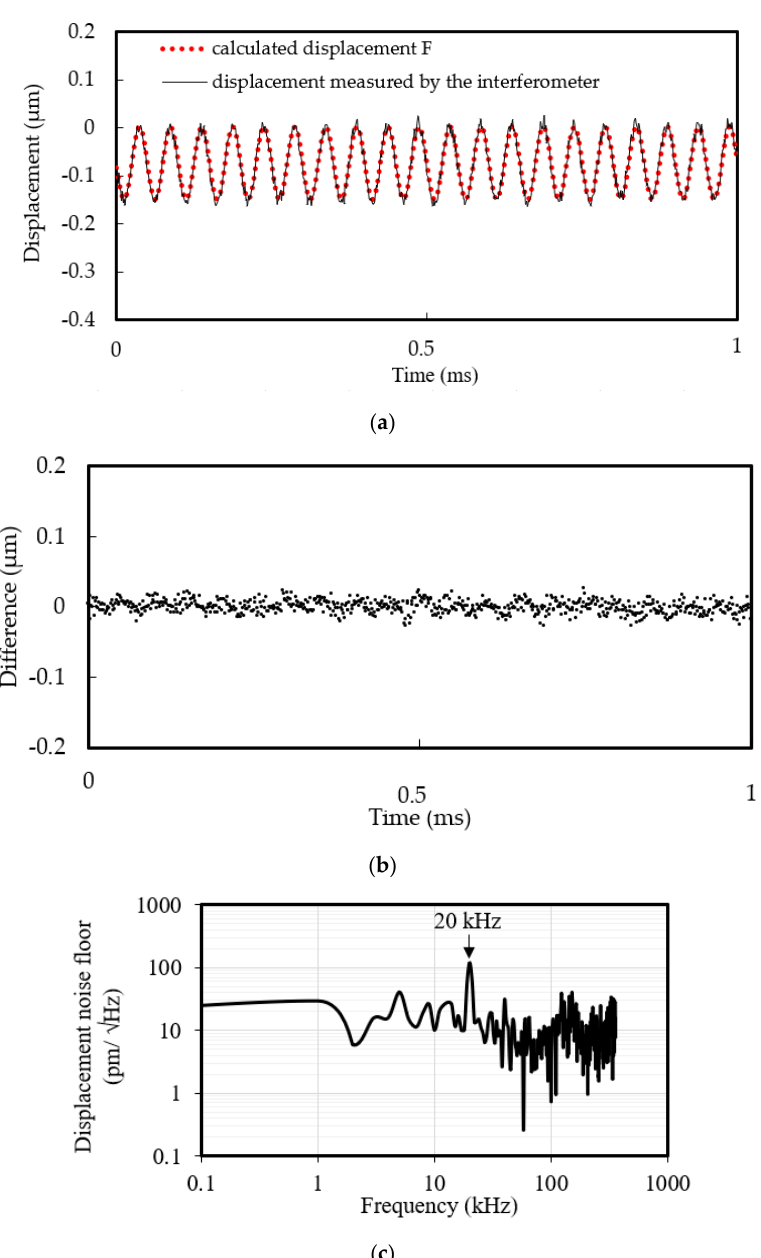
Figure 3. Measurement: ( a ) virtual displacement measured by the interferometer (solid line) compared with the calculated displacement function F = A + B × sin(2 π × 20 kHz × t ) (dot line; see Equation (11), where A = − 0.152 µm and B = − 0.076 µm); ( b ) difference between the result obtained by the interferometer and F; and ( c ) displacement noise floor analyzed from ( b ) by Fourier transform.